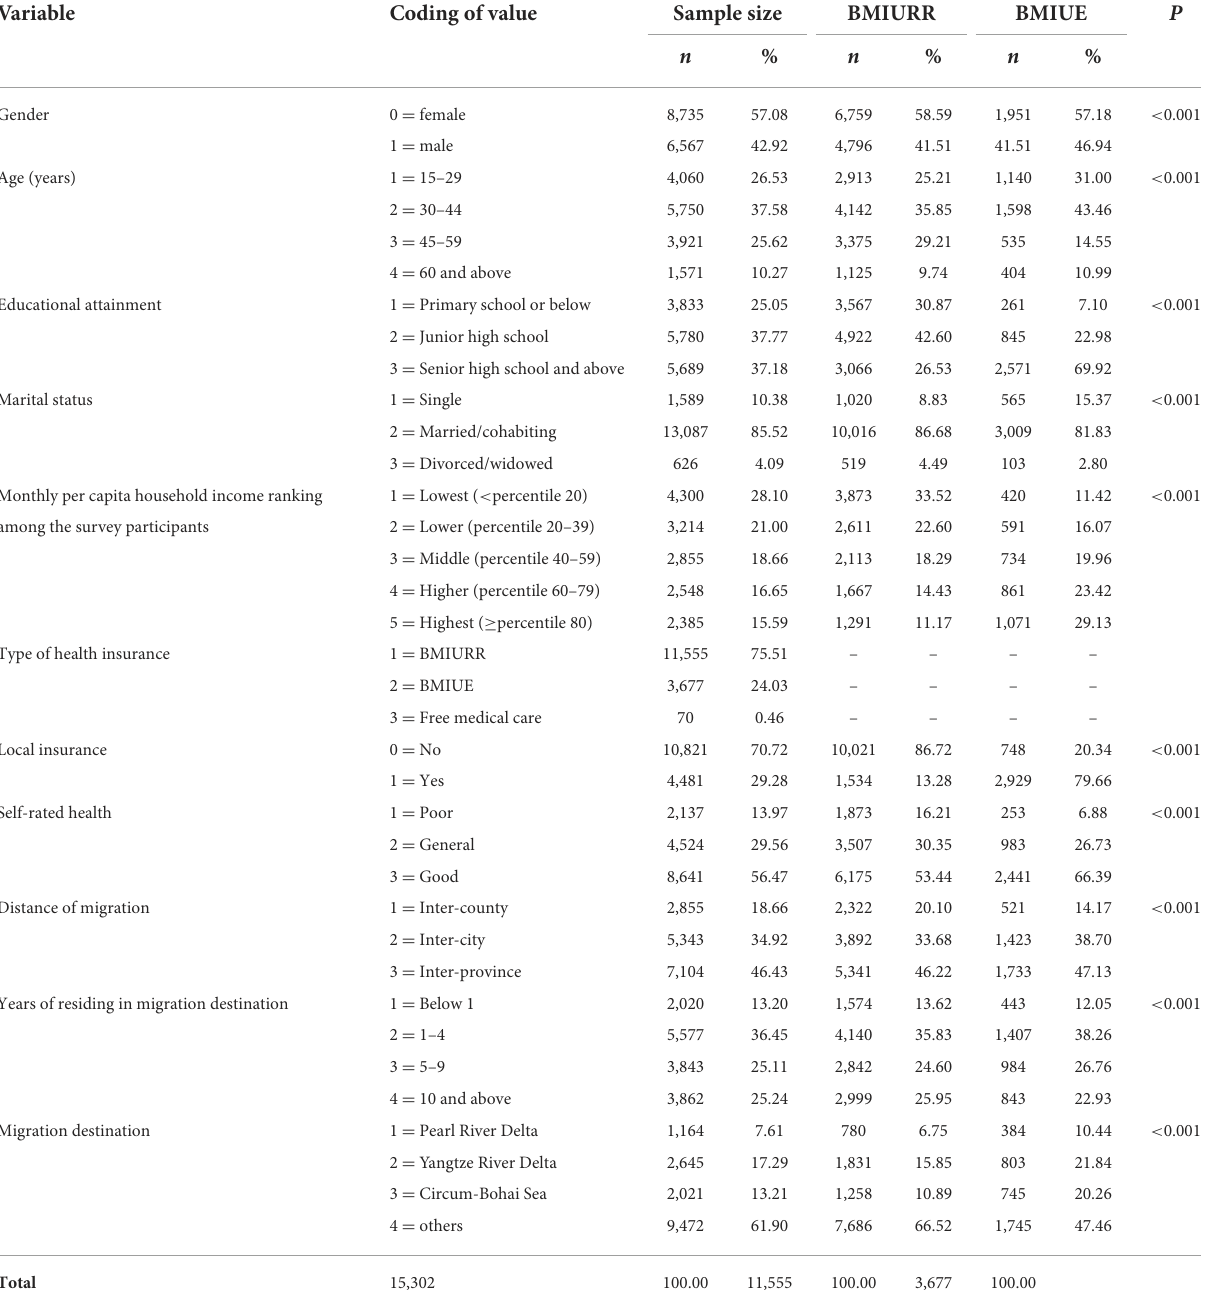
TABLE 1 Characteristics of study participants ( n =